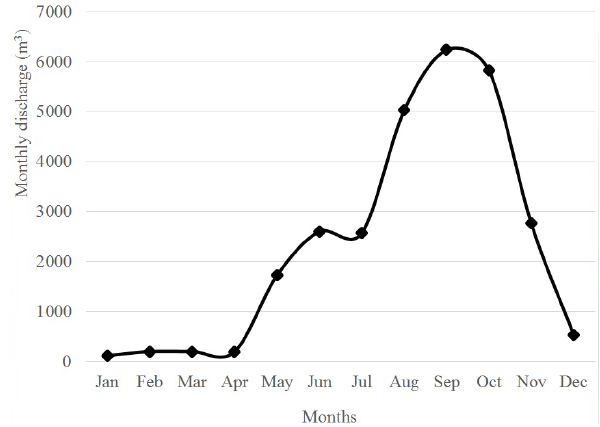
Figure 4. Monthly Water Discharge of Oyan Dam in 2007.